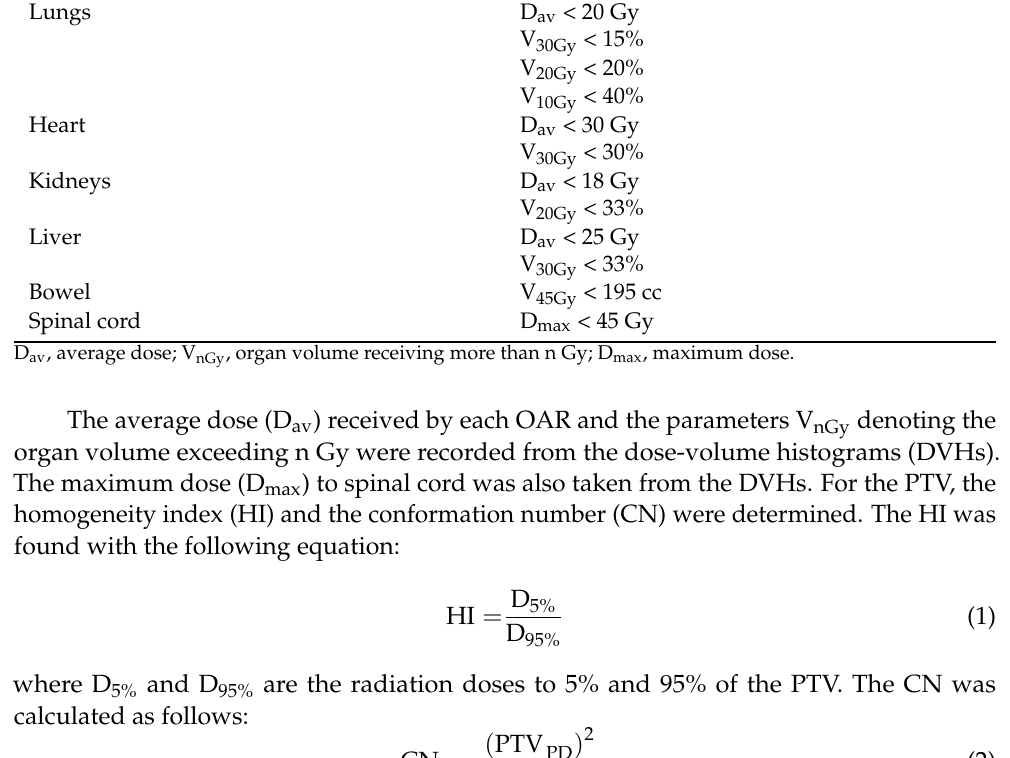
Table 1. Dose constraints used for the generation of 3D-CRT, IMRT and VMAT plans for gastric cancer. Organ-at-Risk Parameter Lungs D av < 20